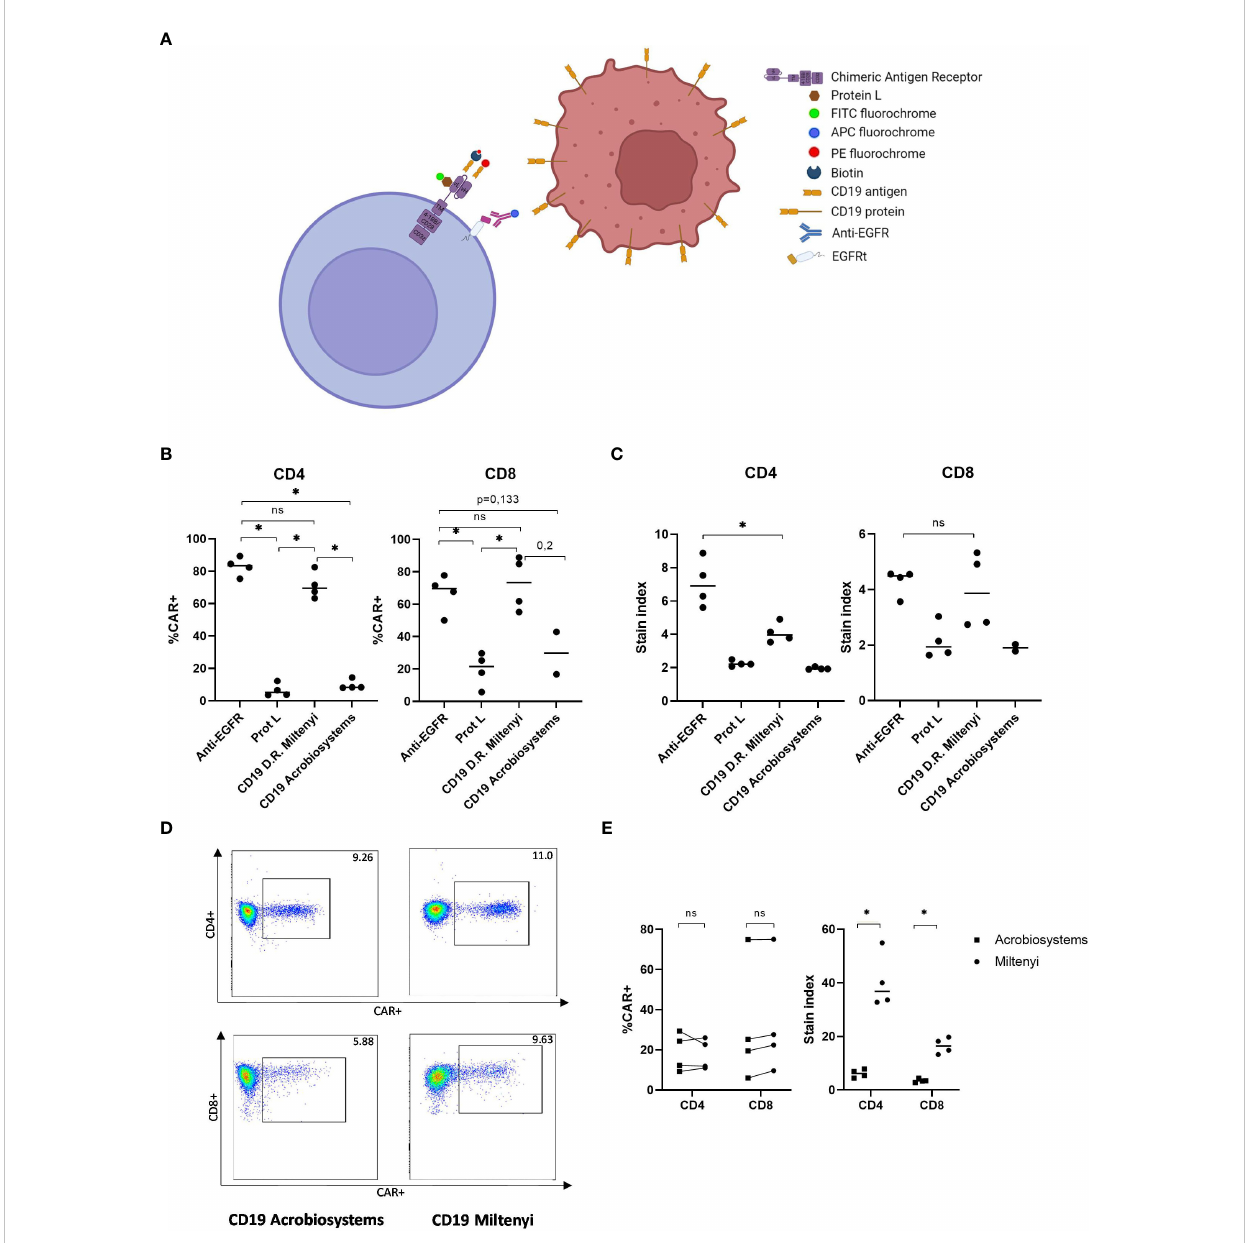
FIGURE 1 Validation of the detection reagent for academic and commercial CD19 CAR-T cells by fl ow cytometry. (A) Illustration of the different detection methods available for the identi fi cation of CAR-T cells by fl ow cytometry. (B) Percentage of detection of academic CD19 CAR-T cells in CD4 and CD8 compartments with different reagents. (C) Stain index of detection of academic CD19 CAR-T cells in CD4 and CD8 compartments with different reagents. (D) Example of fl ow cytometry plot of the identi fi cation of commercial CD19 CAR-T cells with two recombinant CD19 proteins. (E) Percentage (left) and stain index (right) of the detection of commercial CD19 CAR-T cells with two different reagents. Depicted are median and individual values of four independent experiments. P-values between the indicated groups were calculated using unpaired Mann-Whitney U-t tests. ns: non-signi fi cant,